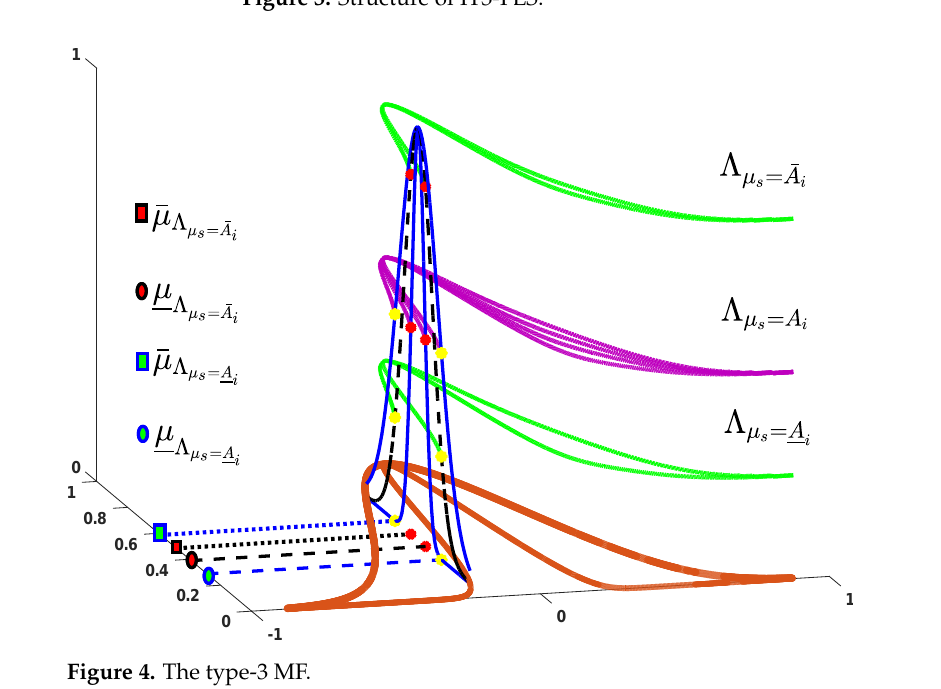
Figure 3. Structure of IT3-FLS.